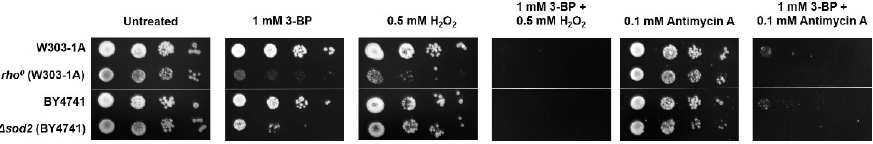
Figure 6. 3 ‐ BP works synergistically with agents inducing oxidative stress and inhibiting mitochondrial ETC (electron transport chain). Spot tests were performed to test the sensitivity of wild type (BY4743, W303 ‐ 1A), rho 0 , Δ sod 2 to 3 ‐ BP in combination with Antimycin ‐ A and H 2 O 2 . Serial type (BY4743, W303-1A), rho 0 , ∆ sod 2 to 3-BP in combination with Antimycin-A and H 2 O 2 . Serial dilutions of strains were spotted on SD medium plates with different concentrations of compounds and incubated for 2 days at 30 °C. and incubated for 2 days at 30 ◦